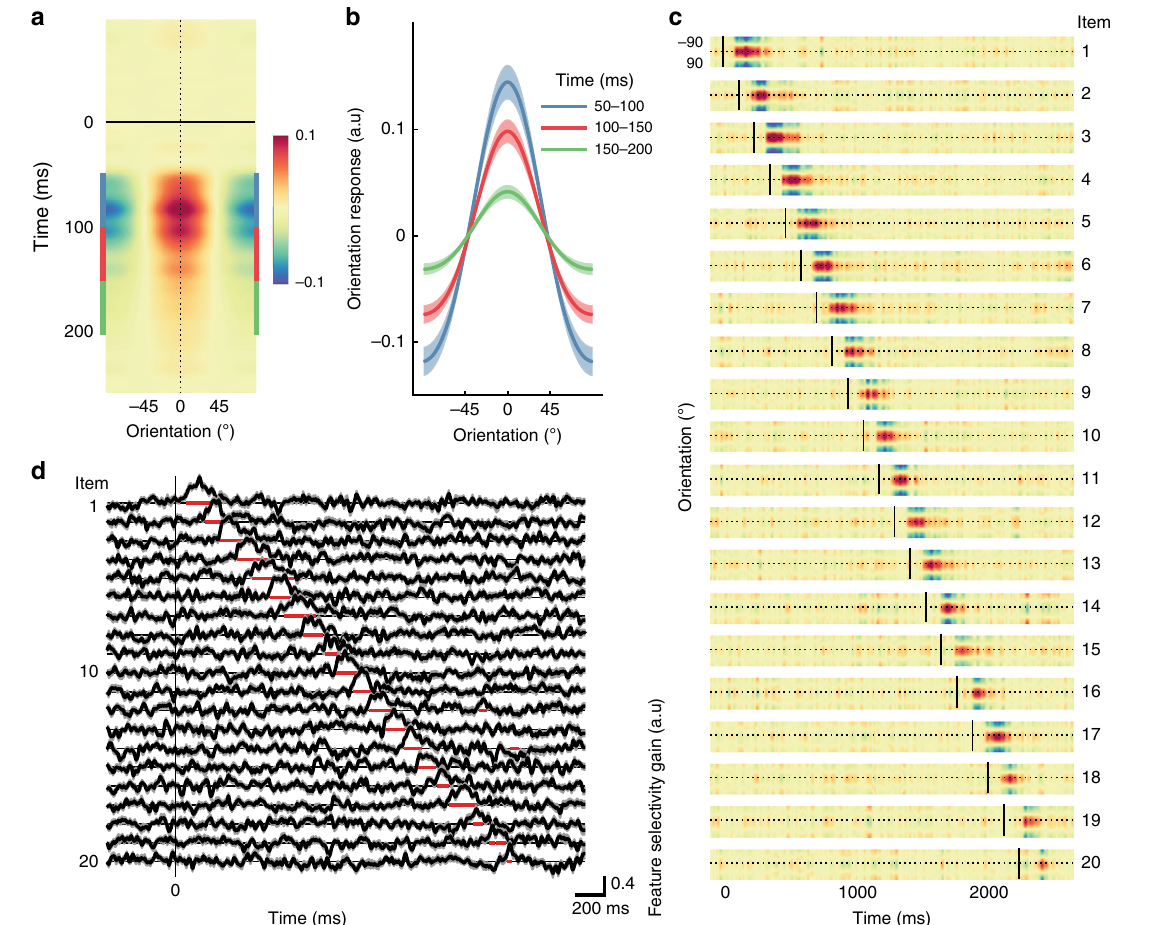
Fig. 5 Feature (orientation) selectivity for RSVP items derived using forward encoding modelling of multivariate patterns of EEG activity in Experiment 2. a Forward encoding results aligned at the time of item onset and the presented orientation across all participants. All representations have been re-aligned so that the presented orientation is equivalent to 0°. b Forward encoding results averaged over 50 ms bins (shown by corresponding colour in ( a ) following each item. Feature-selectivity peaks around 50 – 120 ms after the onset of each item and persists for ~200 ms. c Forward encoding results for each item in the RSVP stream. Vertical black lines indicate the presentation time of each of the 20 items within the RSVP stream. The dotted horizontal line indicates the presented orientation. The colour scale is the same as in panel ( a ). d Gaussian distributions were fi tted to each participant ’ s data for each item in the stream, with the gain showing feature selectivity. The red horizontal line segments underneath each trace indicate timepoints over which feature selectivity was signi fi cantly different from zero (i.e., where feature selectivity was greater than what would be expected by chance; two- tailed, sign- fl ipping cluster-permutation, alpha p < 0.05, cluster alpha p < 0.05, N permutations = 20,000), which occurs immediately following item presentation. Across all panels shading indicates ∓ 1 standard error of the mean across participants. a.u. =